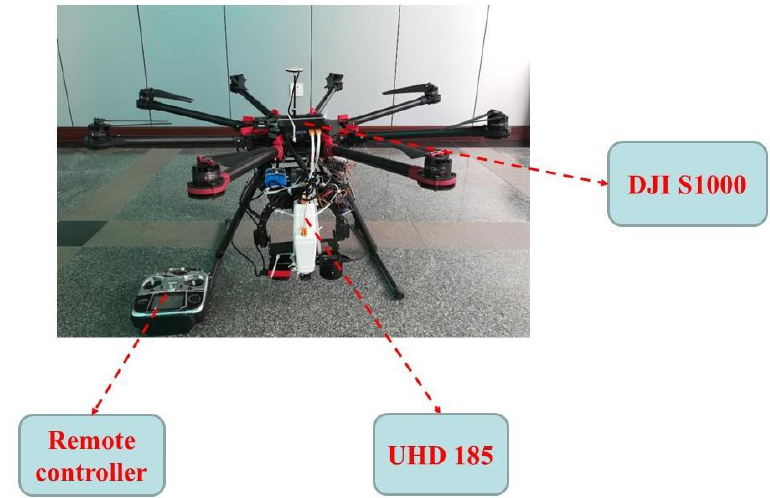
Figure 2. The unmanned aerial vehicle (UAV) remote sensing platform (model DJI S1000) that was used to acquire hyperspectral images. UHD 185: UHD 185 Firefly hyperspectral sensor. The UAV was equipped with a UHD 185 Firefly hyperspectral sensor (UHD 185 firefly, Cubert GmbH, Ulm, Baden-Württemberg, Germany). The sensor has a size of 195 × 67 × 60 mm 3 and a weight